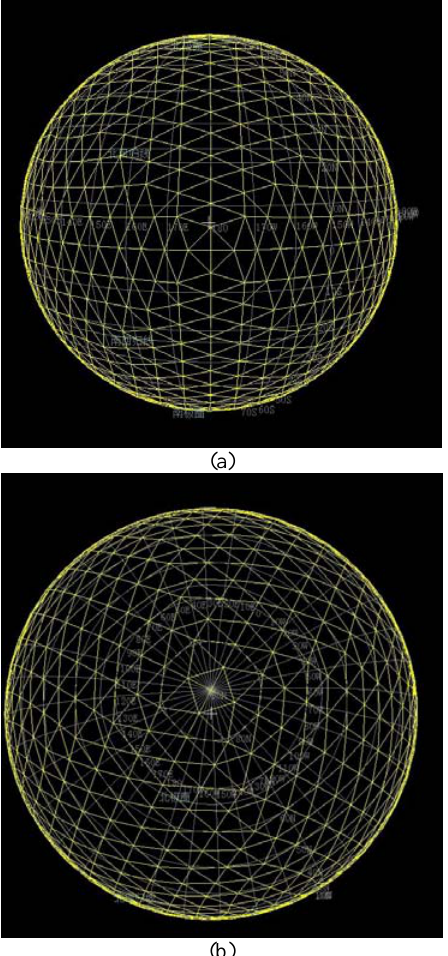
Figure 8 visualization of Snyder projection grids Grids based on octahedron and Snyder projection provides equal-area and hierarchy characteristic. But it is clean that length and angle distortion is inevitable for equal-area projection. To evaluate uniformity of grid, the ratios of max/min length and angle are used in this paper. After each subdivision, all sphere triangles edge lengths and triangle angles are computed and the ratios of max/min value are acquired. The relations of ratios and subdivision levels are shown as figure 9 and 10. In figure 9, the result indicates that the ratio of max/min edge length is 1.7, when the subdivision level is equal to 10. From figure 10, the ratio of max and min angles converges to 3.0.